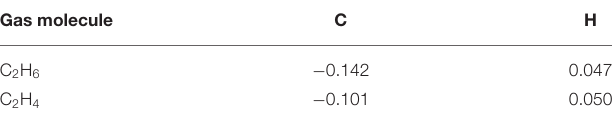
TABLE 1 | The Mulliken atomic charges of gas